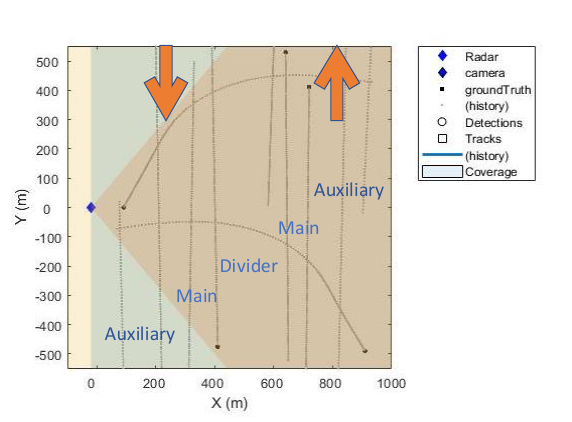
Fig. 3. Ground truth of vessel targets, division of waterways and driving direction.